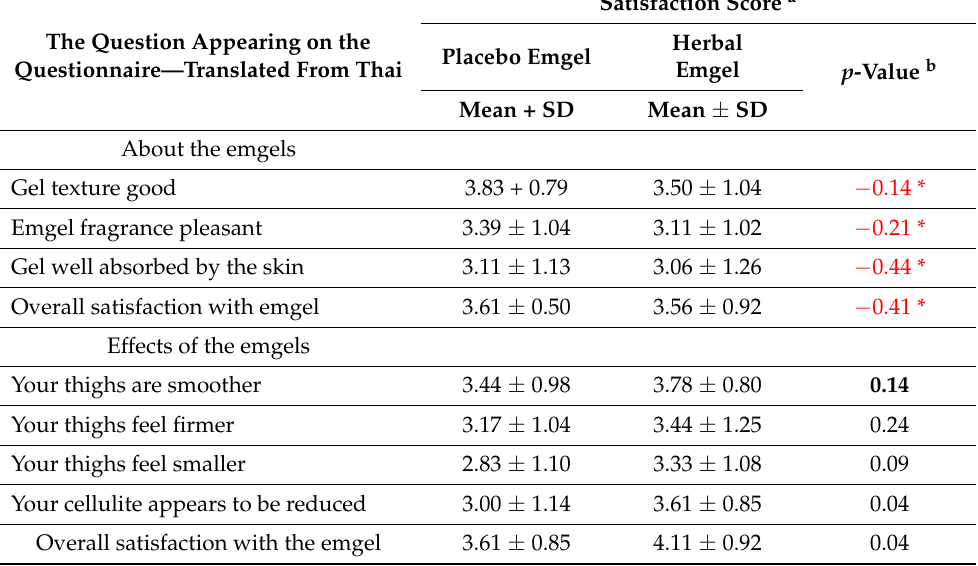
Table 4. Self-evaluation questionnaire about perceptions on cellulite-related properties after 12 weeks of treatment.